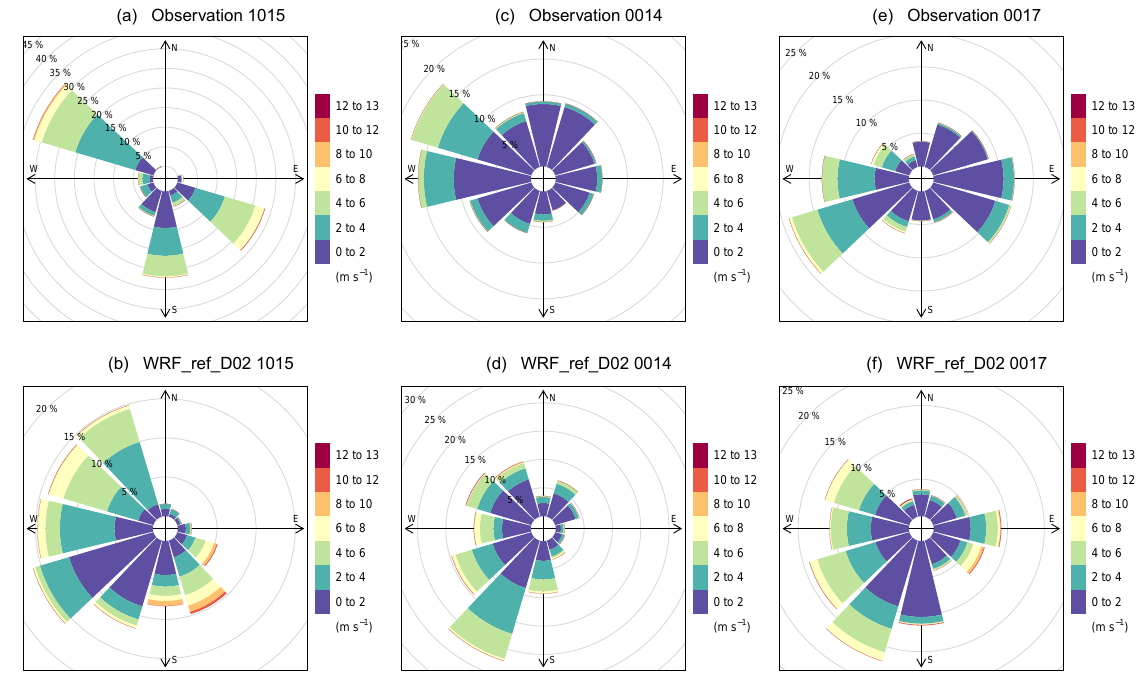
Figure 7. Wind roses based on measured and simulated (WRF_ref_D02) wind speed and direction at four stations – 0018 (a, b) , 1015 (c, d) , 0014 (e, f) and 0017 (g, h) – in the Kathmandu Valley for the time period of January–June 2013 based on 3h data. Shown are wind speed (color) (ms − 1 ) and the frequency of counts by wind direction (%).